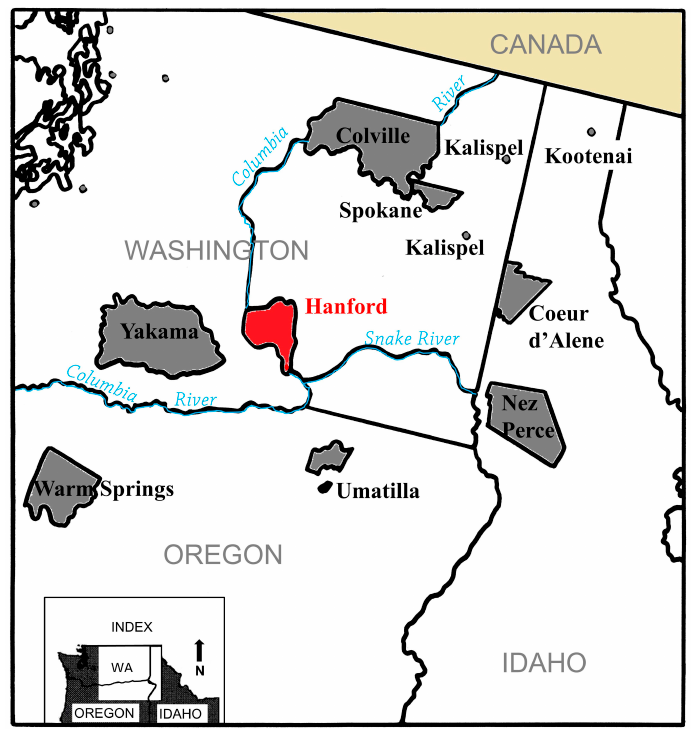
Figure 3. Hanford Nuclear Reservation, shown in red, was located in the state of Washington. Nine Native American reservations surround it. Figure modified from Edward Liebow in Hanford, Tribal Risks, and Public Health